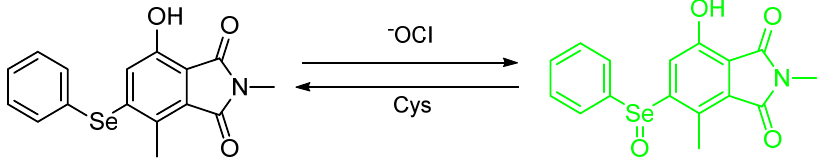
Figure 32. Structure of 7–hydroxy–4–methyl–5–(phenylselanyl)isobenzofuran–1,3–dione probe ( Probe–1 ) reported by Mulay et al.